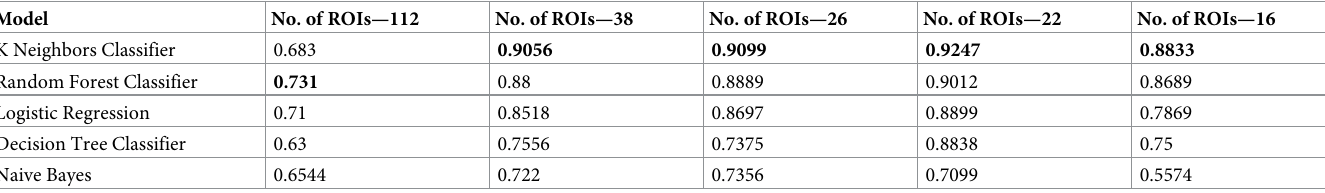
Table 2. Accuracy across different ROIs for the classification shown by various models.